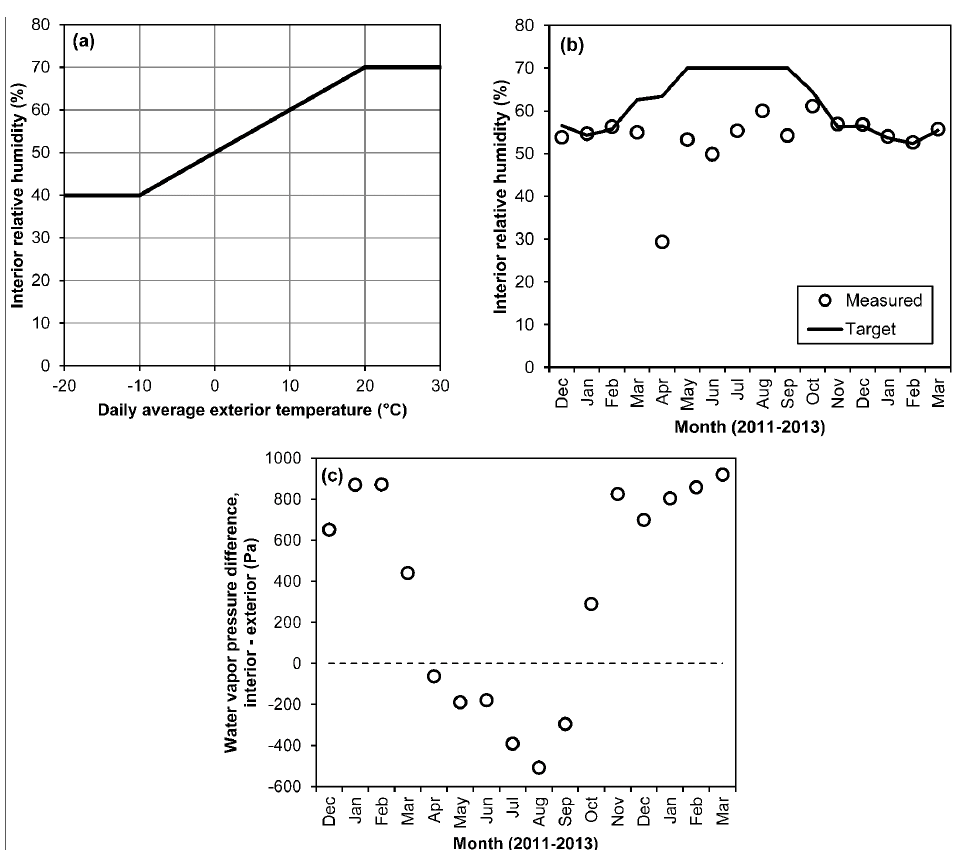
Figure 2. ( a ) Target interior relative humidity as a function of outdoor temperature; ( b ) Target and measured monthly average interior relative humidity over the monitoring period; ( c ) Difference between monthly average interior and exterior water vapor pressure over the monitoring